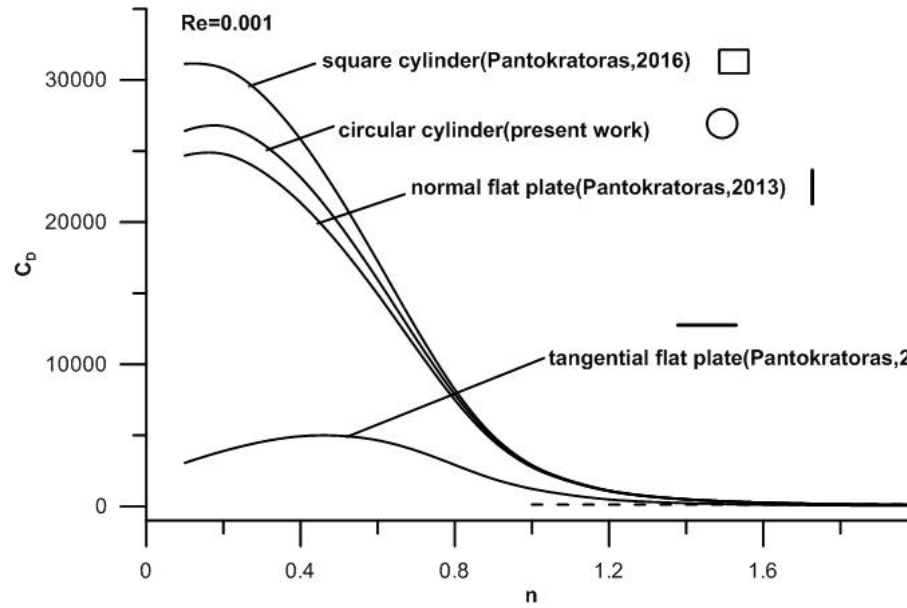
Figure 2. Variation of drag coefficient as a function of the power-law index for Re = 0.001.